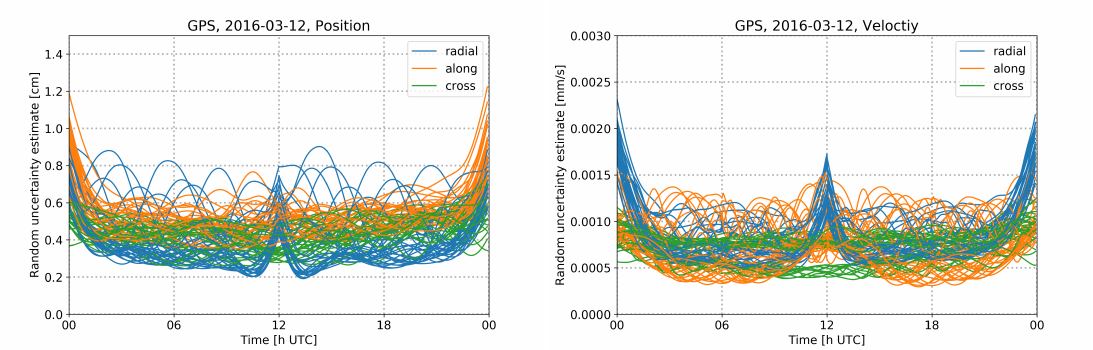
Figure 3. Propagated random uncertainty estimates (based on propagating standard errors) from Bernese for the constellation of GPS satellites on an example day (12 March, 2016), for position ( left ) and velocity ( right ), for the radial, along-track, and cross-track components. Coverage factor of 2